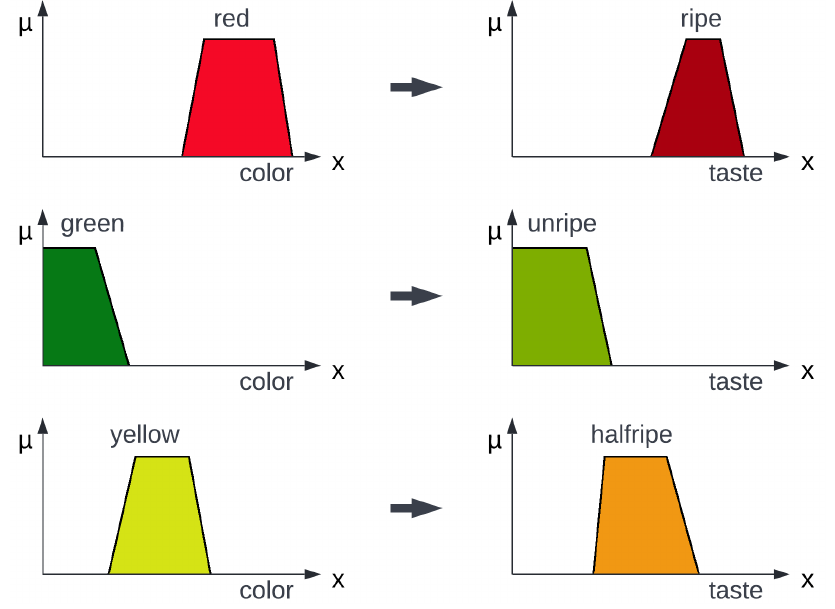
Figure 1. Example of a fuzzy rule interpolation inference.